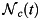
The plot shows the average number of classes in the population as function of time for various initial fitnesses.The fitnesses are chosen from Eq (1) with (a) κ = −1 (b) κ → 0 and (c) κ = 1/4. For each κ value, the plot shows Nc(t) in both high mutation (top panels) and low mutation (bottom panels) regimes. The straight line in all plots shows Nμ + 1.